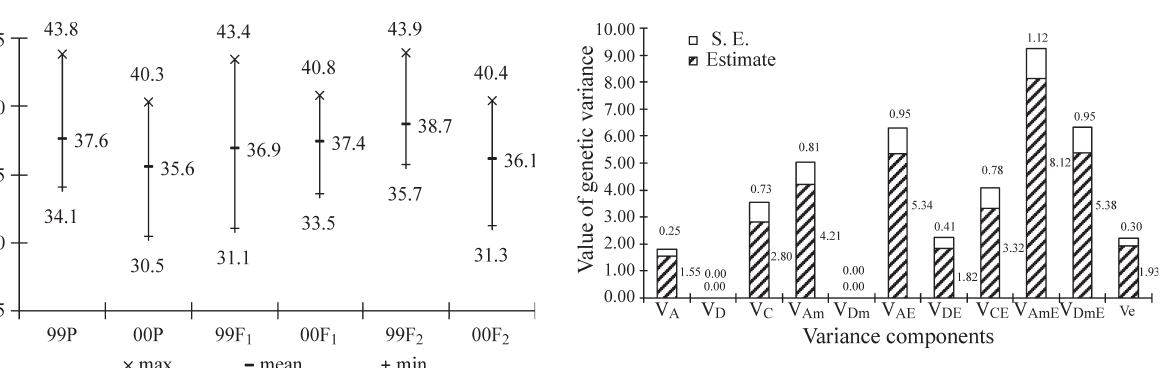
Figure 2 - Estimates of genetic variance components for rape oil content. Values on the upper and right side of the columns are standard error (SE) and variance component estimates. All estimates except for V D and V Dm were significant at p =